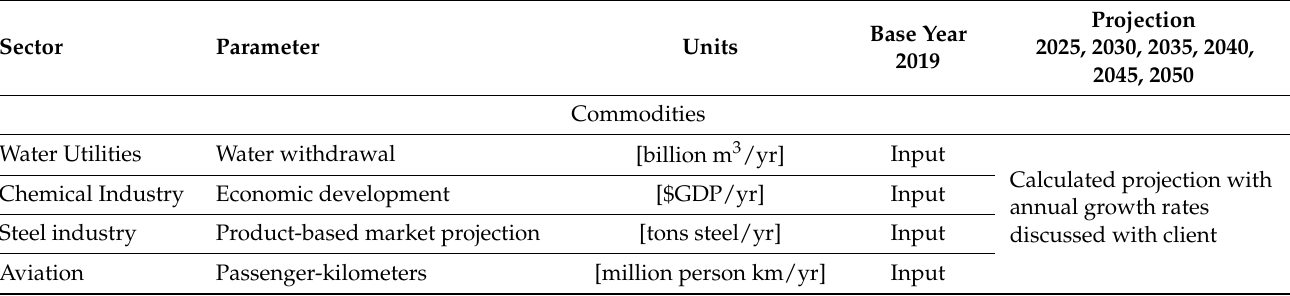
Table 23. Examples of energy-related key performance indicators (KPIs) for net-zero target setting, calculated with OECM 2.0 for four